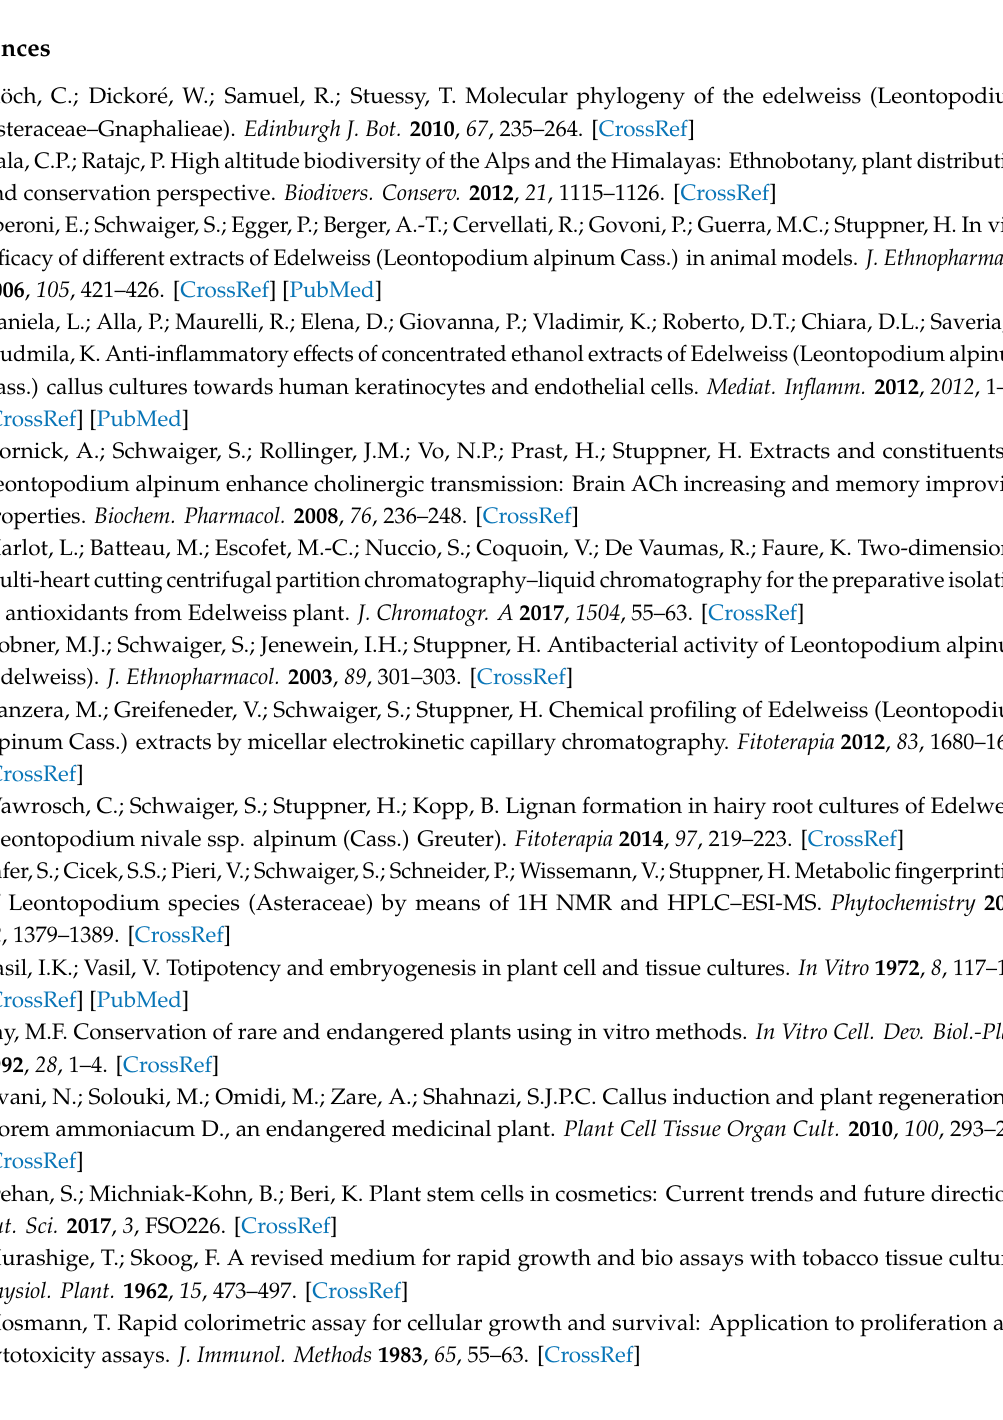
Table S1. Expression profiles of human keratocyte (HaCaT) cells in response to LACCE. Table S2.